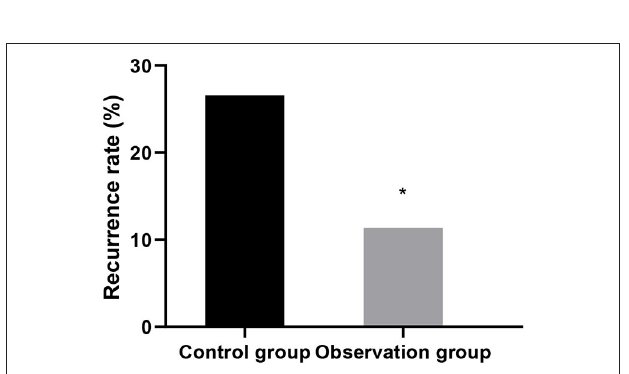
FIGURE 4 | Comparison of recurrence after 12 months between the two groups. Compared with control group,* P < 0.05.